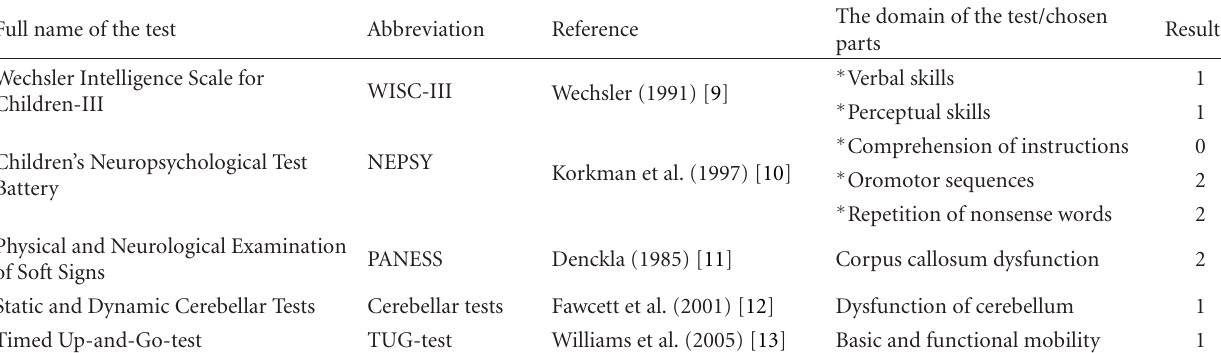
Table 1: Neuropsychological evaluation of the proband at 30 years of age.